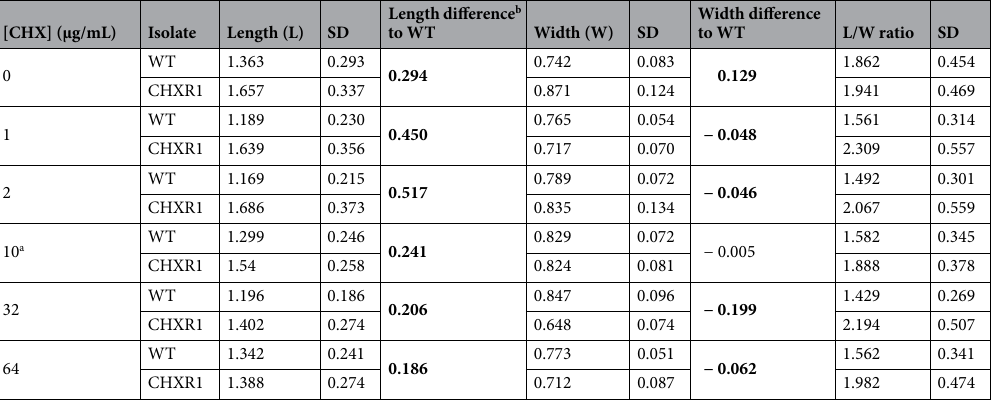
Table 3. A summary of the mean and standard deviation (SD) values of measured cell lengths and widths by SEM for WT and CHX-adapted E. coli (CHXR1) after 30-min of exposure to CHX. Values are based on images of individual cells visualized from five SEM images collected at 5000× magnification (n = 100 cells) for two bioreplicates. All bolded values are significant with P < 0.01 by Student’s t-test. a 10 µg/mL was selected as this is the arithmetic MIC value. b Difference from WT was determined by subtracting mean length or width of WT from the mean length or width values of